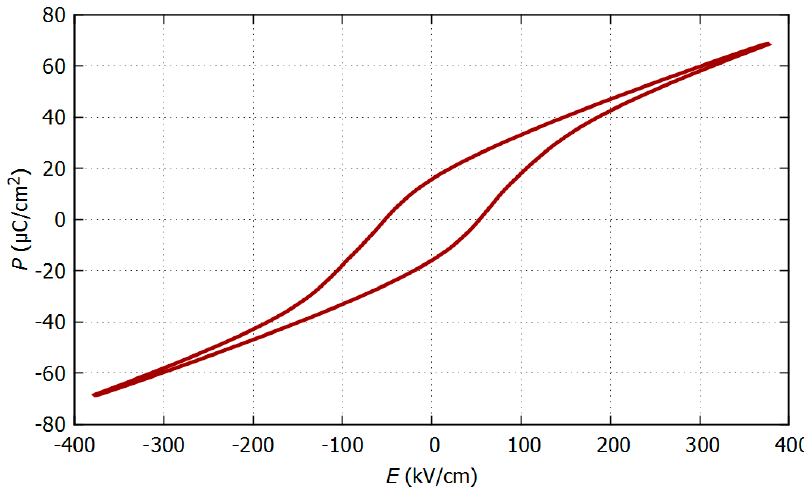
Figure 5. Polarization-electric field ( P - E ) loop of the 200-nm PZT on glass with AZO 5-μm-gap IDE electrodes. The measurement was performed at 100 Hz.